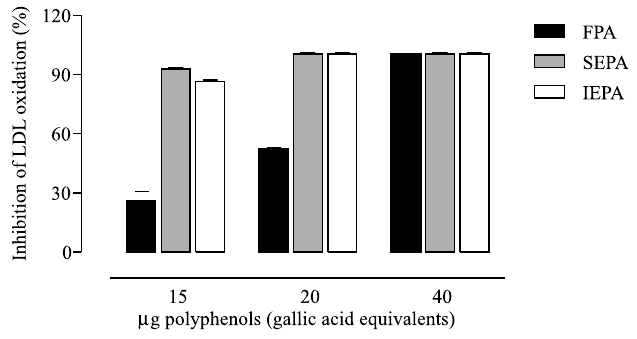
FIGURE 4 - Inhibitory activity of phenolic-rich polar fractions in hep-LDL oxidation mediated by Cu 2+ done according to Frostegard et al. (1990). Oxidation was conducted in the presence of the fractions FPA, SEPA and IEPA from seaweed Halimeda incrassata and evaluated by TBARS formation. Values expressed as mean ±